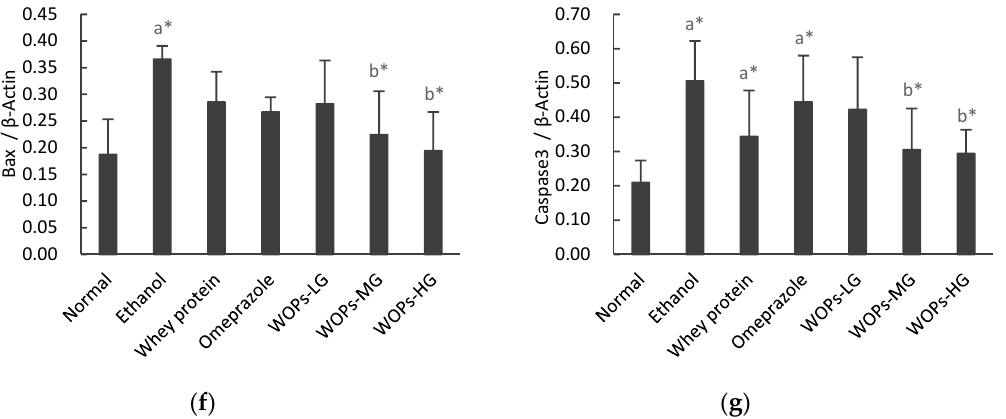
Figure 5. Effect of WOPs on the apoptosis-related protein expression in rats. ( a ) Apoptosis-related protein levels were analyzed by Western blot. N, normal control group; E, ethanol group; P, whey protein group (220 mg/kg body weight); O, omeprazole group (20 mg/kg body weight); WL, WOPs-LG (220 mg/kg body weight); WM, WOPs-LG (440 mg/kg body weight); WH, WOPs-HG (880 mg/kg body weight). ( b ) Effect of WOPs on the expression of NF- κ B p65 in gastric tissue of rats. ( c ) Expression of I κ B α in gastric tissue of rats. ( d ) Expression of HSP70 in gastric tissue of rats. ( e ) Expression of Bcl-2 in gastric tissue of rats. ( f ) Expression of Bax in gastric tissue of rats. ( g ) Expression of Caspase-3 in gastric tissue of rats. Data are expressed as mean ± SD (n = 10); a, b, d represent compared with the normal group, ethanol group, and omeprazole group separately; * p < 0.05 was considered to have statistical differences. NF- κ B p65, nuclear factor- κ B p65; I κ B α , inhibitor kappa B α ; WOPs-LG, 220 mg/kg of walnut oligopeptides group; WOPs-MG, 440 mg/kg of walnut oligopeptides group; WOPs-HG, 880 mg/kg of walnut oligopeptides group.